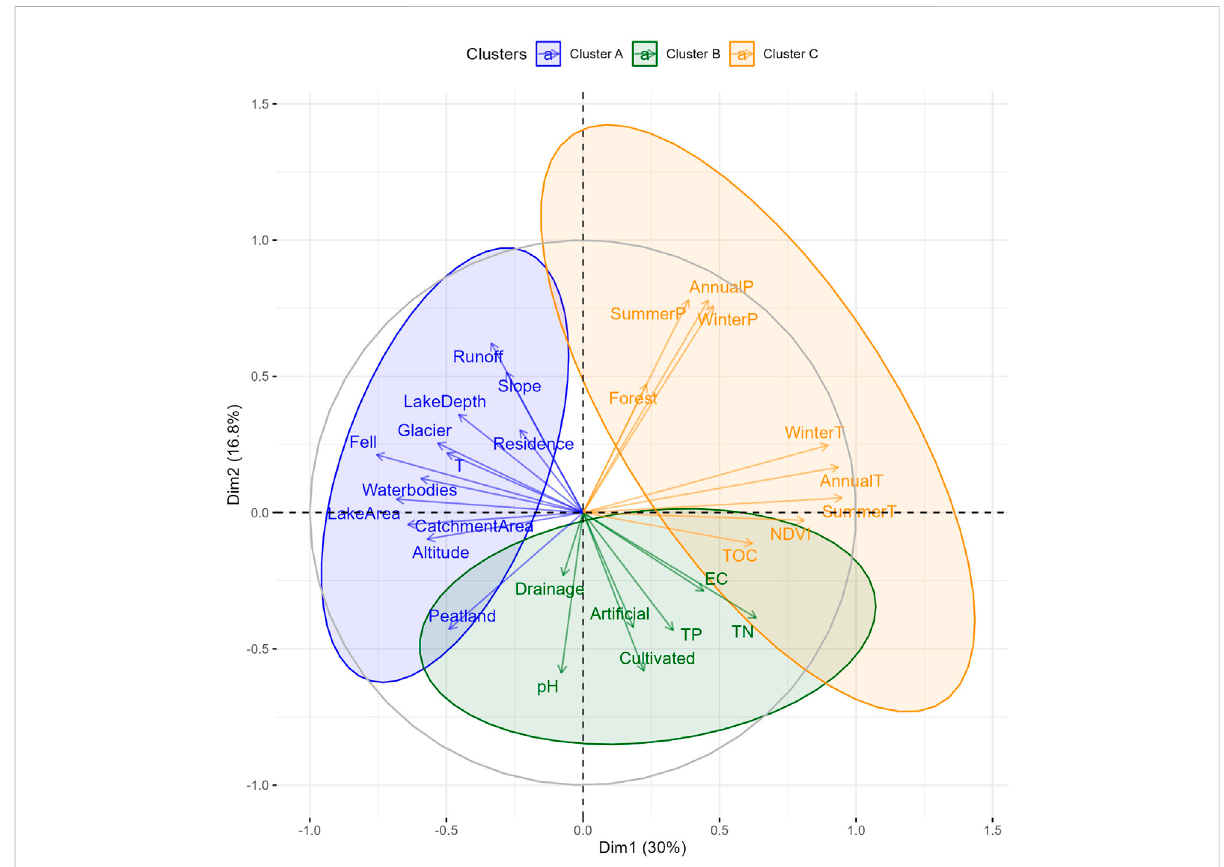
FIGURE 3 PCA analysis of the transformed variables depicting the two main principal components (PC) of parameter loading with the three de fi ned clusters labeled in blue, green and orange (Clusters A, B and C, respectively). The two PCA axes explain 36.8% of total variability in the